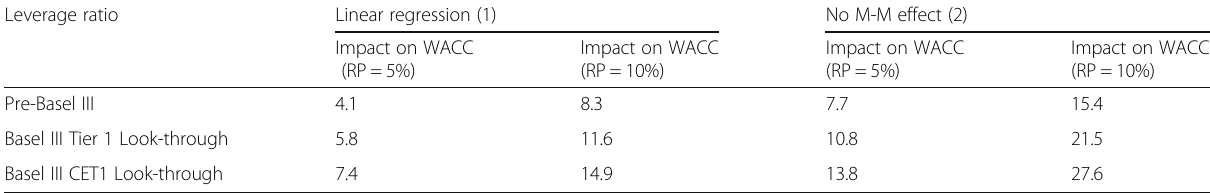
Table 2 Swiss G-SIBs: impact on WACC resulting from a 1 percentage increase of the leverage ratio measured in bps Leverage ratio Linear regression (1) No M-M effect (2) Impact on WACC (RP =